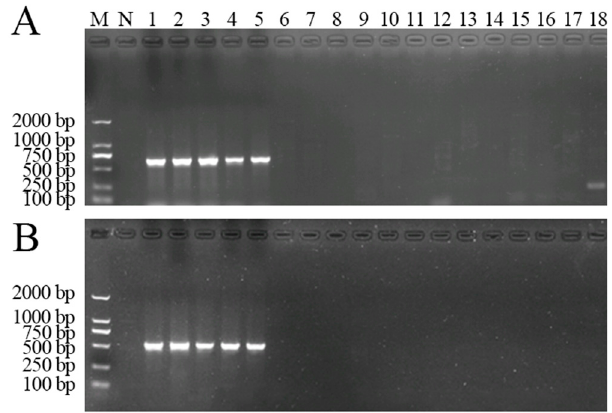
Figure 4. Specificity of seminested PCR detection of A. phaeospermum. ( A ) Specificity of the AP1- 1/AP1-2 primer; ( B ) specificity of the AP1-2/AP3-1 primer. M: DL2000 marker; N: negative control;